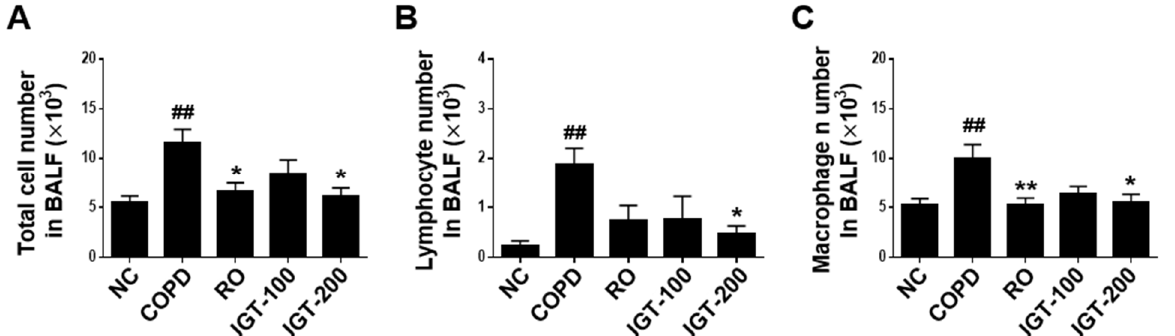
Figure 4. Effects of JGT on inflammatory cell counts in BALF. ( A ) Numbers of total inflammatory cells. ( B ) Numbers of lymphocytes. ( C ) Numbers of macrophages. NC, normal control mice; COPD, CS & LPS-treated mice; RO, roflumilast (5 mg/kg) along with CS & LPS-treated mice; JGT-100, JGT (100 mg/kg) along with CS & LPS-treated mice; JGT-200, JGT (200 mg/kg) along with CS & LPS-treated mice. Data are displayed as means ± SEM. ## p < 0.01 compared with NC; * p < 0.05 and ** p < 0.01 compared with COPD.